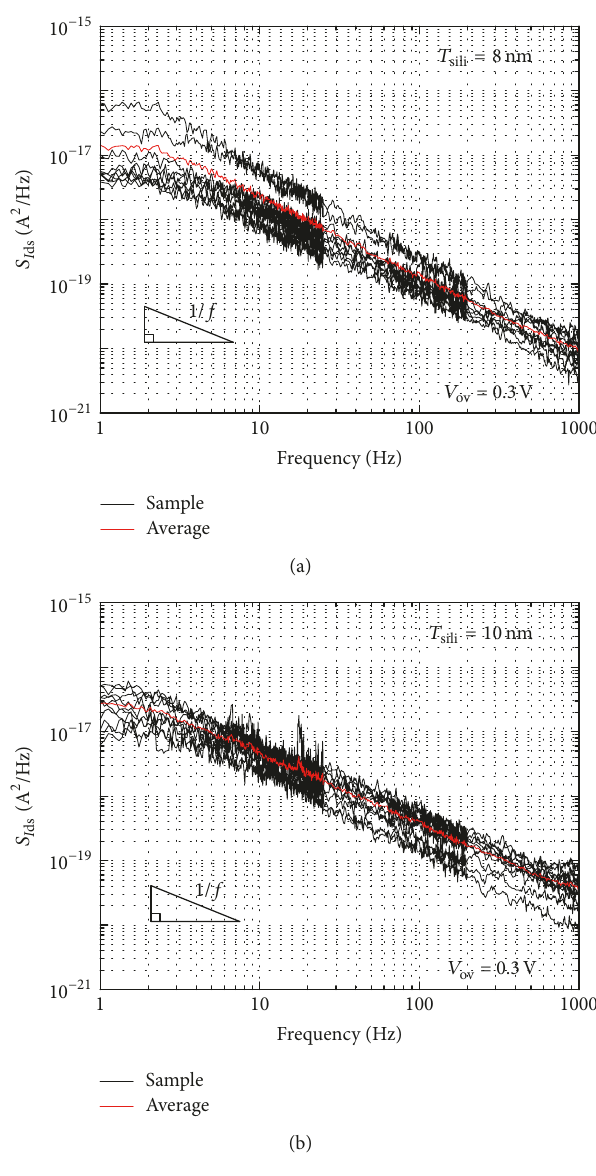
Figure 7: Drain current noise spectral density ( 𝑆 𝐼 of 0.05 V and the overdrive voltage ( 𝑉 𝑇 of (a) 8 and (b) 10nm. The number of measured devices, close sili to the average 𝐼 , is 10 ds